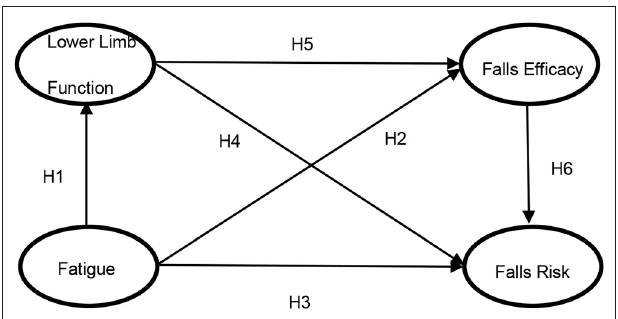
FIGURE 1 | Hypothesized Structural Equation Modeling